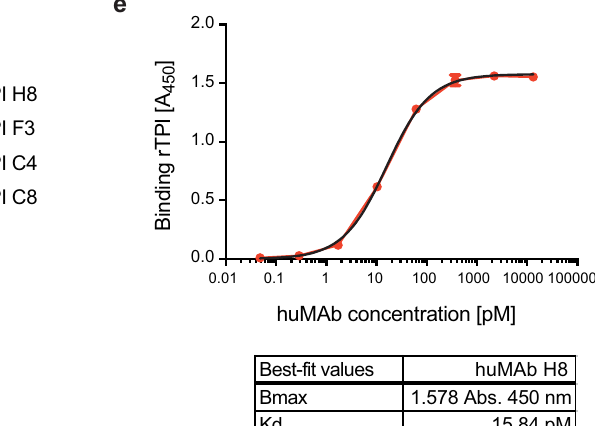
Fig. 4 Characterisation of anti-TPI mAbs. a Binding domain of H8 / F3 mAbs (red) was identi fi ed by western blot analysis using recombinant His-, or Strep-tagged TPI-fragments and classi fi ed as detectable ( + ) or non-detectable ( − ) by H8/F3 mAbs in comparison to anti-Strep-tag antibodies. b S. aureus TPI structure (3m9y.pdb) was visualised by EzMol2.1 with the identi fi ed aa of the H8/F3 binding domain in red. c Epitopes of mAb C4 (green) and mAb C8 (blue) were identi fi ed by PepSpot technology using overlapping 15mer TPI peptides with overlapping sequences of 11 aa. d Competition ELISA. Binding of DyLight-649-conjugated anti-TPI mAb H8 to recombinant rTPI coated on ELISA MaxiSorp plate, was competed with unconjugated, indicated mAbs. Binding was determined by fl uorescence measurement (Ex 646/Em 674). Data are presented as mean ± s.d. ( n = 2). e Saturation binding curve was generated by plotting absorbance signals (OD 450nm ) of increasing amounts of anti-TPI huMAb H8 to rTPI coated on ELISA MaxiSorp plate using the GraphPadPrism 8.4 software. Kd was calculated by non-linear fi tting and the equation for one-site binding model [Y = Bmax*X/(Kd +